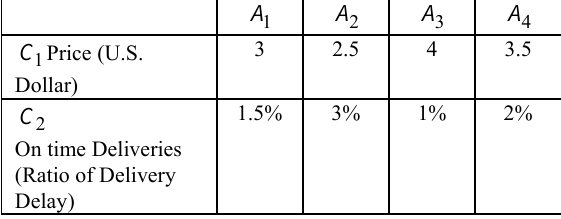
Table 4. Quantitative information